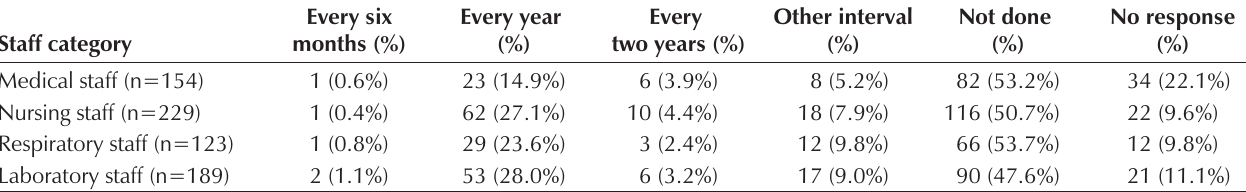
Frequency of ongoing tuberculin skin test (TST) screening in acute care hospitals with a TST screening